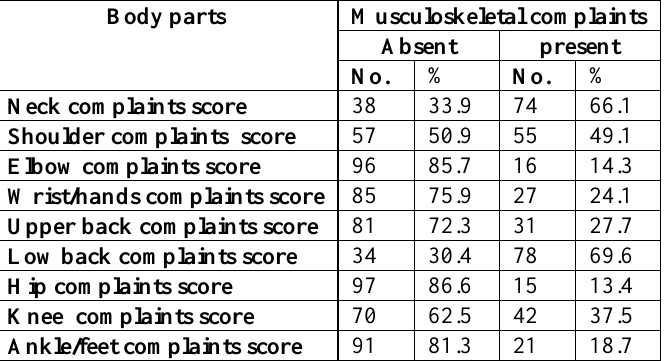
Table 2: Distribution of dentists according to presence or absence of musculoskeletal complaints by body parts.